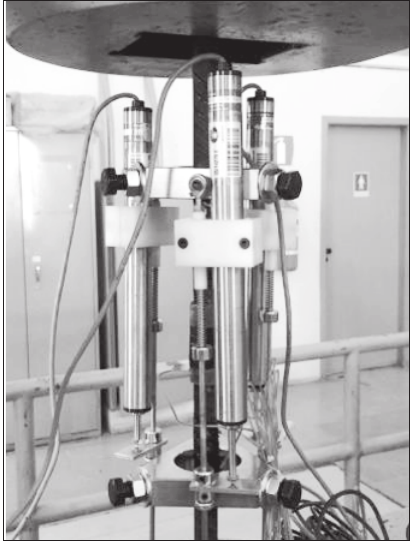
Load cycle scheme for determining slip, modified from DS-G-6647-029202 [36] (A-Method 1) and ISO 15835 [1] (B-Methods 2 and